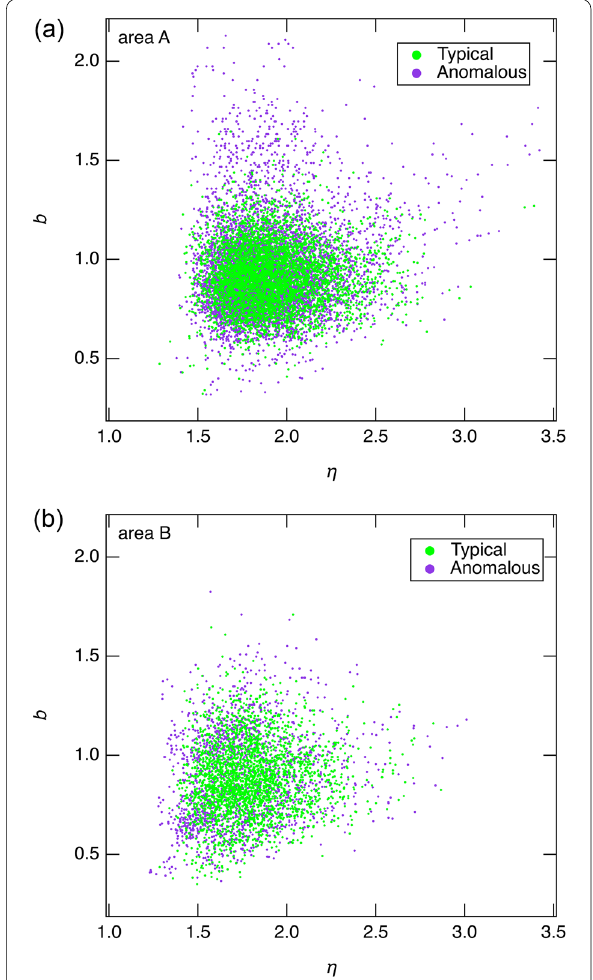
50 and l 0.4 ◦ in a area A and b area B. Fig. 13 b versus η for N = = Green and purple dots indicate the cases where the PDDs of the both indices are typical and where the PDDs of one of the two indices are 50 and l 0.4 ◦ . a Area = = anomalous,